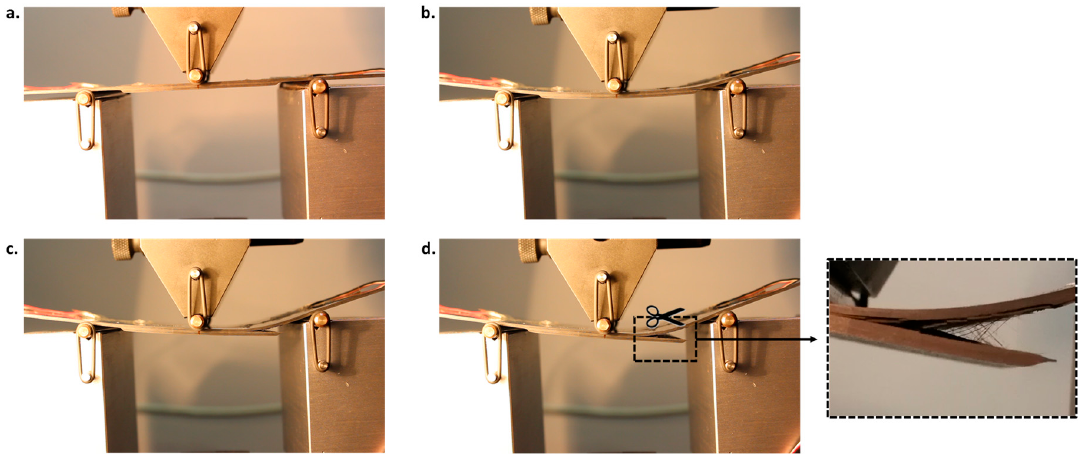
Figure 11. Deformed shape at: ( a ) test initiation; ( b ) debonding onset; ( c ) intermediate debonding state and ( d ) final debonding.